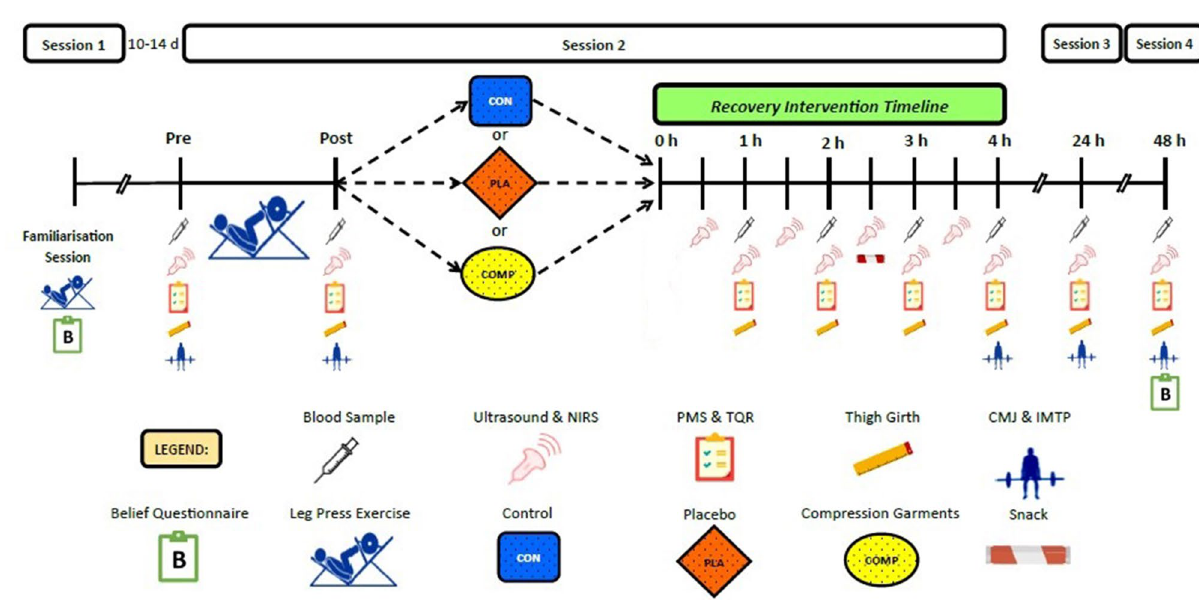
Figure 4. Schematic diagram of testing